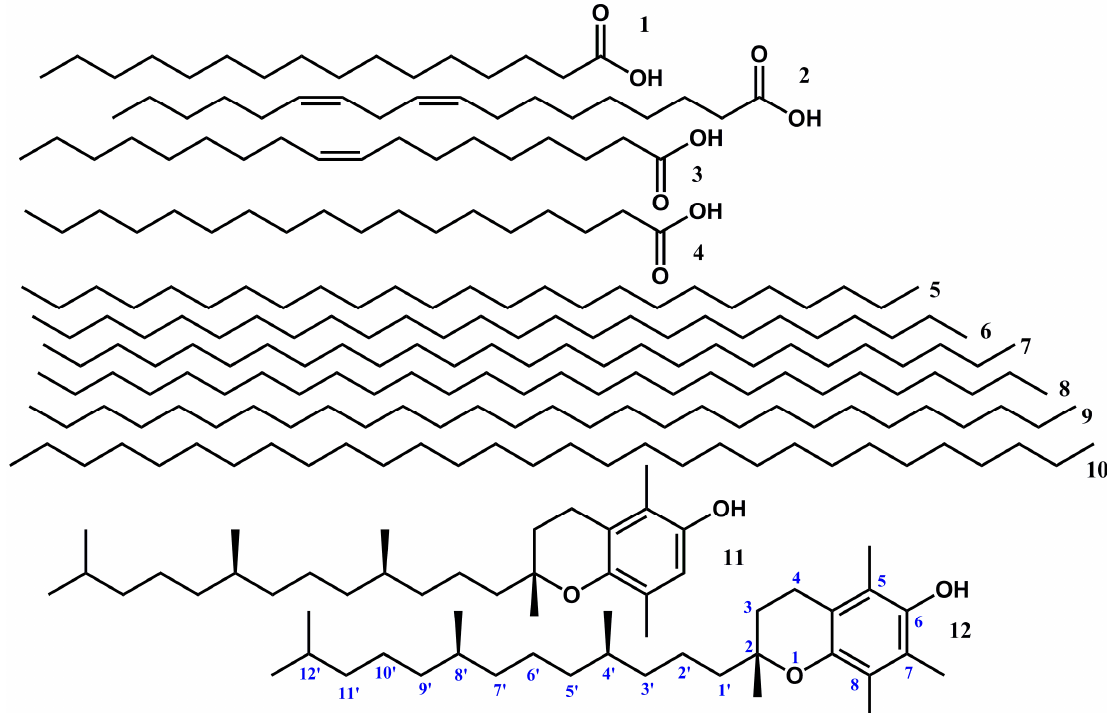
Figure 2. Structures of non-polar compounds identified from the leaves of B. laciniosa, N. variegata and E. spectabile. 1 n -Hexadecanoic acid (Palmitic acid); 2 9 Z ,12 Z -Octadecadienoic acid; 3 9 Z -Octadecenoic acid (Oleic acid); 4 Octadecanoic acid (Stearic acid); 5 n -Pentacosane; 6 n -Hexacosane; 7 n -Heptacosane; 8 n -Octacosane; 9 n -Nonacosane; 10 n -Triacontane; 11 β -Tocopherol; and 12 α -Tocopherol (Vitamin